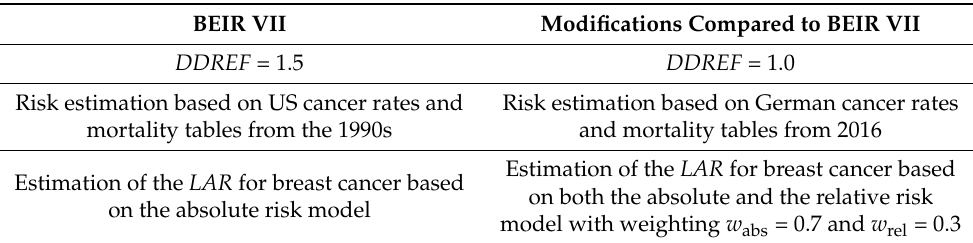
Table 1. Differences between the BEIR VII Committee’s assessment of the LAR and our assessment. BEIR VII Risk estimation based on US cancer rates and Risk estimation based on German cancer rates mortality tables from the 1990s and mortality tables from 2016 Estimation of the LAR for breast cancer based Estimation of the LAR for breast cancer based on both the absolute and the relative risk on the absolute risk model model with weighting w abs = 0.7 and w rel =